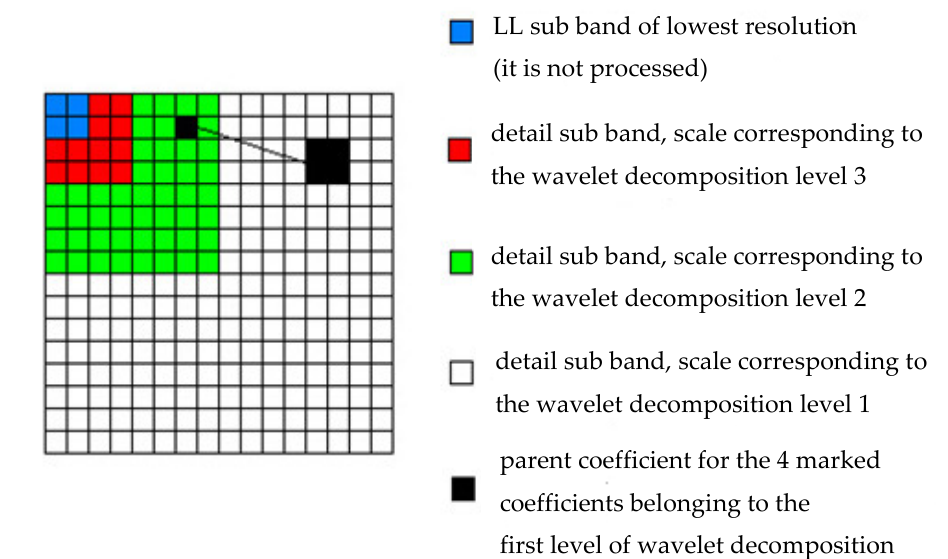
Figure 1. Wavelet decomposition (blue—lowest resolution sub-band is not processed; red—low resolution sub-bands, corresponding to wavelet decomposition level 3, are processed by soft truncation; green, white—detail sub-bands, corresponding to wavelet decomposition level 2 and 1, are processed based on the significance map).